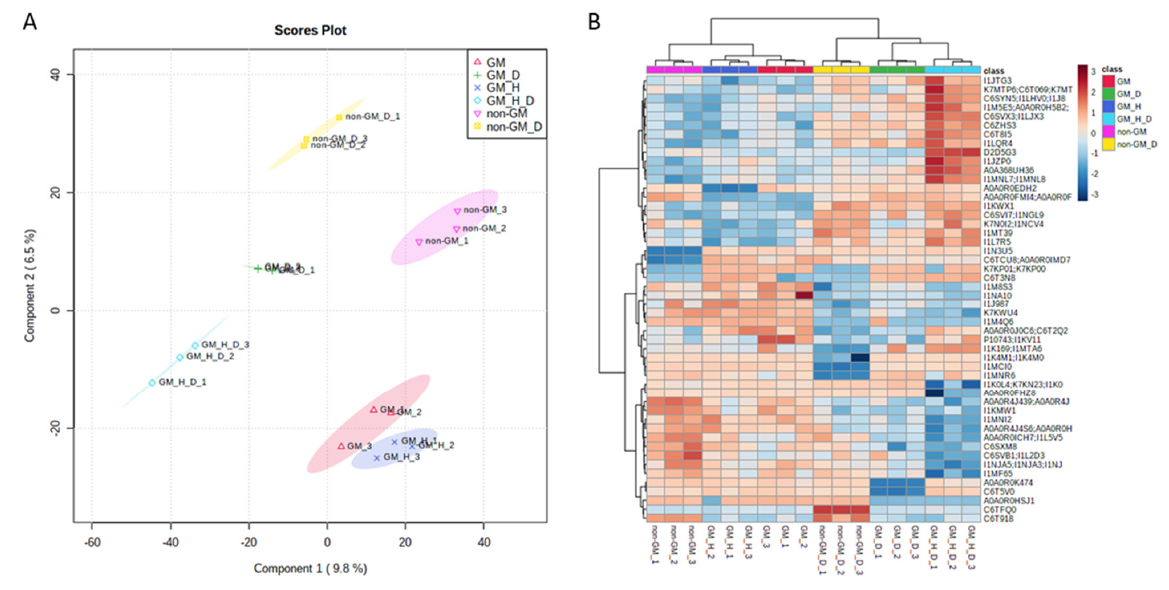
Figure 3. Exploratory analysis of proteomic profiles. ( A ) Scores plot for Partial least square-discriminant analysis (PLS-DA). Ovals show 95% confidence interval for each treatment. This is a scatter plot for the 2 components having the greatest variations. Observations that are similar will fall close to each other displaying a clustering-like pattern. Component 1 ( X -axis) contains 9.8% of the total variation and component 2 contains 6.5%. ( B ) Hierarchical Clustering heatmap. Hierarchical clustering was performed considering the top 50 FDR corrected t-test p value (<0.05) passing proteins. Horizontal axis shows the biological samples analyzed in the study and vertical axis denotes Uniprot accessions for the proteins. On top of the heatmap samples are identified by treatment. Dendrogram for samples is shown on top of the heatmap and proteins’ dendrogram on left side of the heatmap. Dark blue to dark red color gradient denotes lower to higher expression.